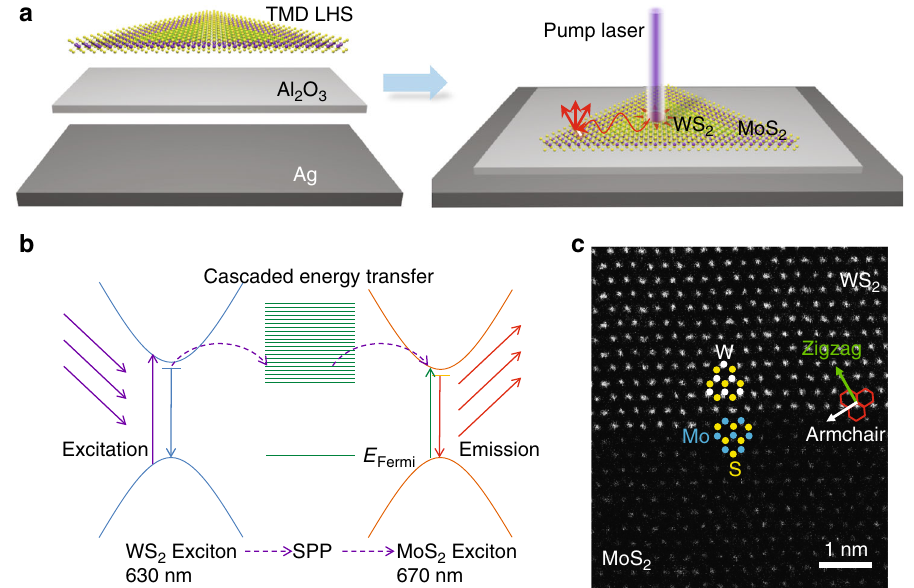
Fig. 1 Schematic illustrations of the metal-oxide-semiconductor (MOS) structure and the cascaded exciton energy transfer process assisted by surface plasmon polariton. a A colloidal Ag plate is coated with ~3 nm Al 2 O 3 immediately after it is taken out of the solution. The as-grown monolayer-thick WS 2 /MoS 2 lateral heterostructure (LHS) is transferred to the Ag plate using a polymethyl methacrylate (PMMA)-assisted transfer technique. An excitation laser is normally incident on the WS 2 region, and the photoluminescence (PL) from the interface or a speci fi ed MoS 2 region is detected. b Energy transfer diagram describing the exciton – SPP – exciton conversion process. c High-resolution annular dark- fi eld scanning transmission electron microscopy (STEM) image of a monolayer LHS grown with an atomically sharp